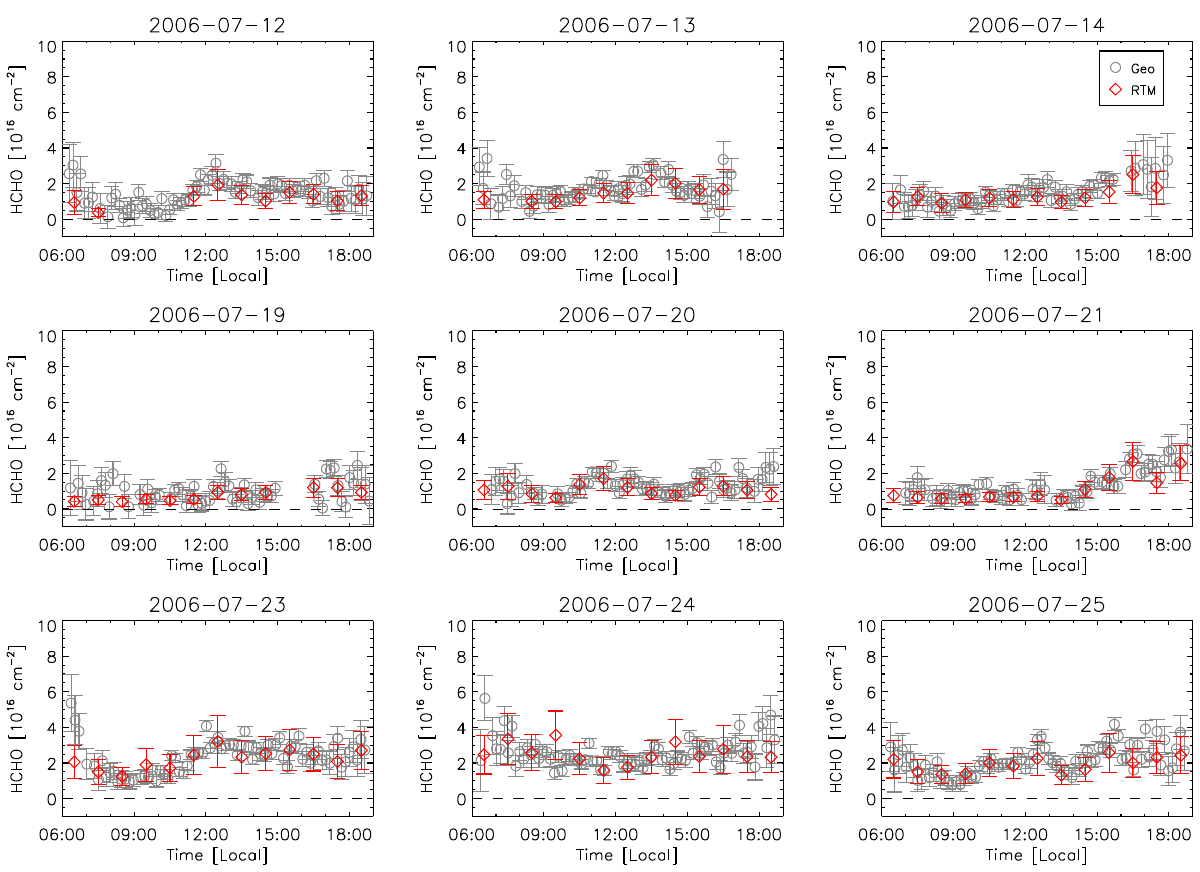
Fig. 4. Time series of HCHO vertical column densities (VCDs) on the 9 cloud-free days during the PRIDE-PRD2006 campaign. The grey circles represent HCHO VCDs calculated by the geometric approach (i.e. Eq. 1), and the red diamonds refer to HCHO VCDs derived from the HCHO vertical distribution retrieval (i.e. Fig.